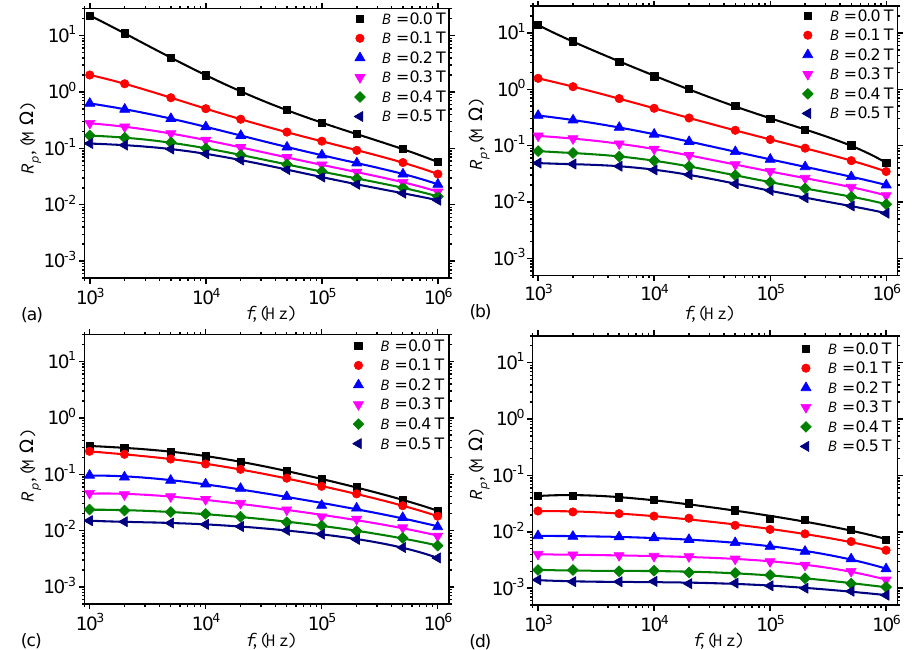
Figure 5. Variation of resistance R p with frequency f , at fixed values of magnetic flux density B . ( a ) hMAC. ( b ) hEMAC 1 . ( c ) hEMAC 2 . ( d ) hEMAC 3